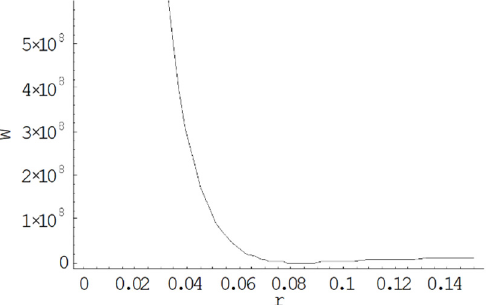
Figure 3. Graphical representation of convexity of the total cost function versus the number of units.